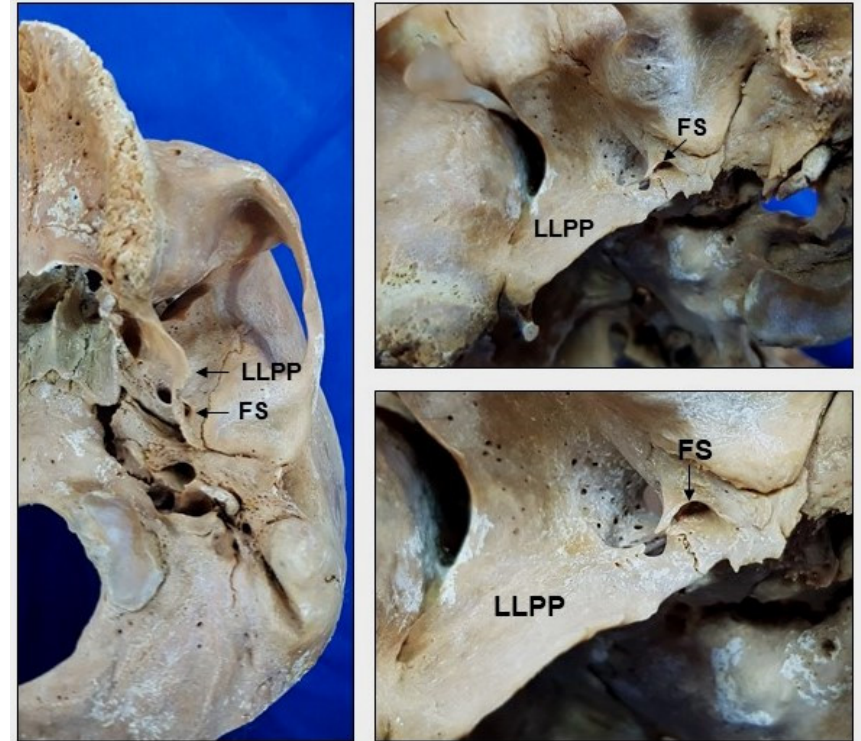
Figure 5. Inferior view of the skull. Note the presence of the foramen spinosum (FS) in relation to the lateral lamina of the pterygoid process (LLPP) of the sphenoid bone.